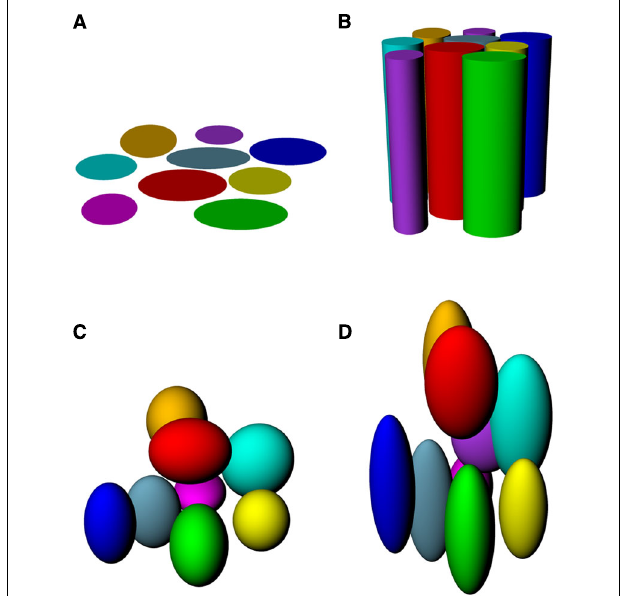
FIGURE 3 | Hypothetical structure of place fields in volumetric space. (A) Place fields might be “flat” and not extend into the vertical dimension at all; (B) Place fields might extend into the vertical dimension, but only show spatial structure in the horizontal plane; (C) Place fields might be globular, extending into all three dimensions and being distributed evenly throughout the volume of space; (D) Place fields might be volumetric, but asymmetric (different scale in vertical than horizontal